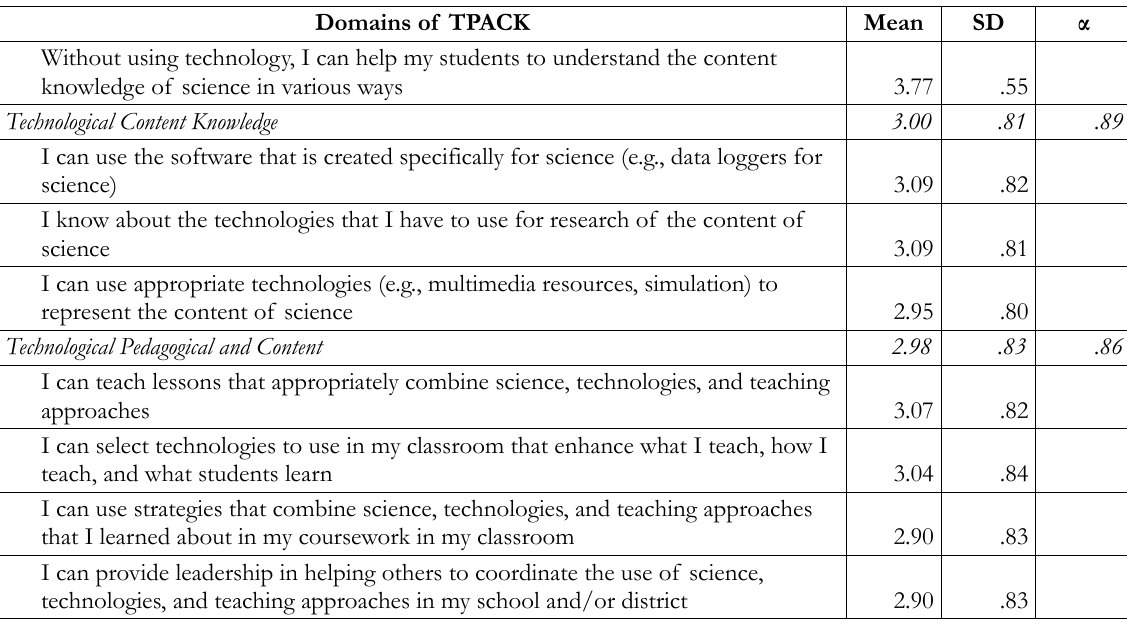
Table 4. Level of The Technological Pedagogical Content Knowledge of Indonesian science teachers